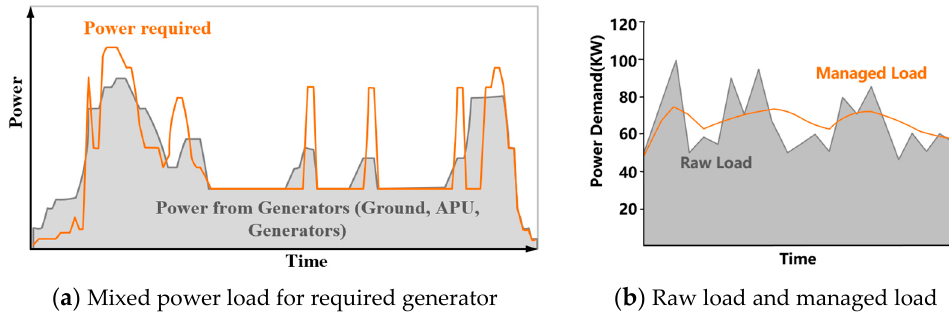
Figure 7. The electrical load profile for the aircraft power system.